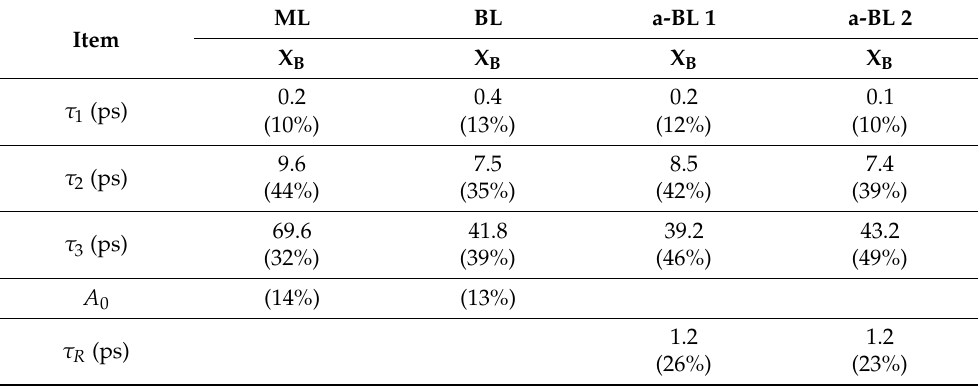
Table 2. Fitted decay parameters for resonant 1.89 eV excitation.